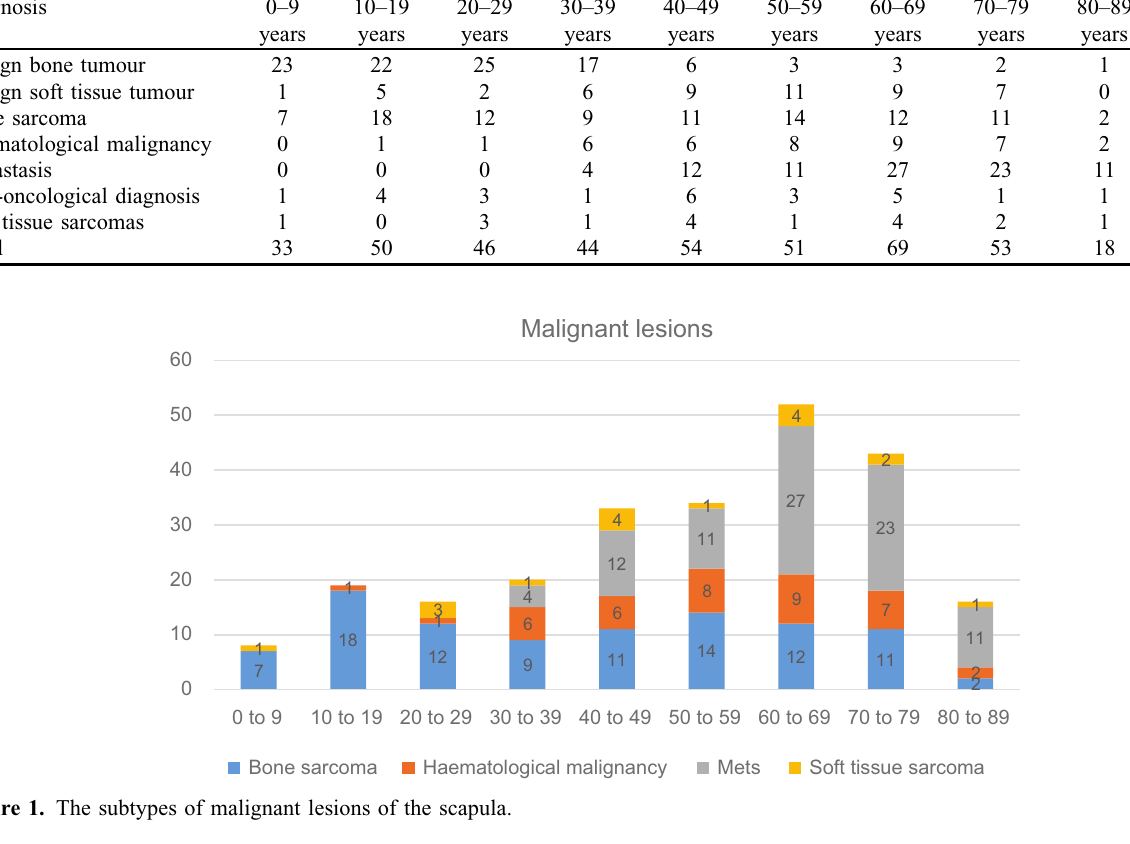
of their clinical and radiological pictures. The median age for the whole cohort was 47 years (range 0–88), and 60% ( n = 249) of the study population were male. Fifty-two percent ( n = 216) of the patients had involvement of the right-sided scapula.